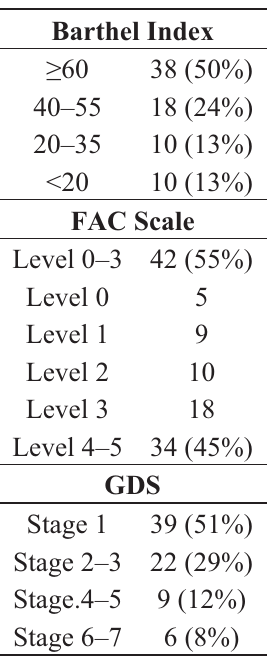
Table 1. Baseline data at the time of inclusion in the